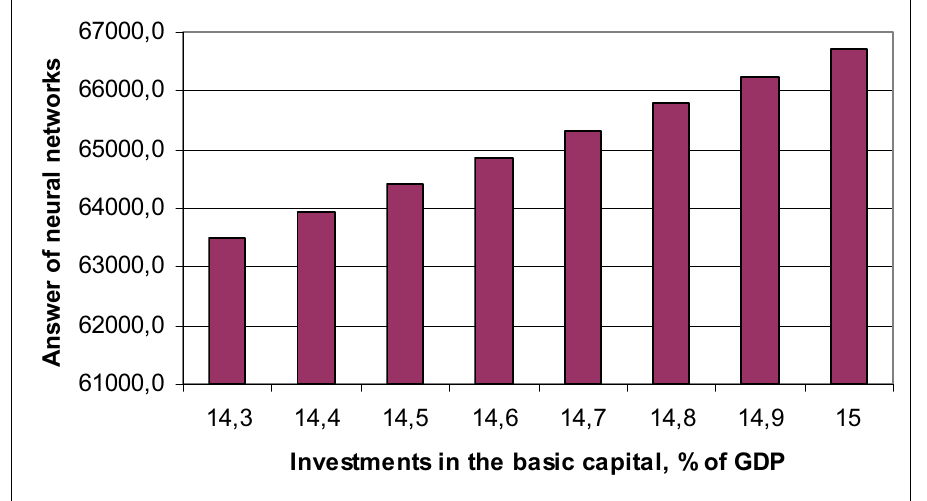
Fig. 6. The influence of investments in the basic capital over